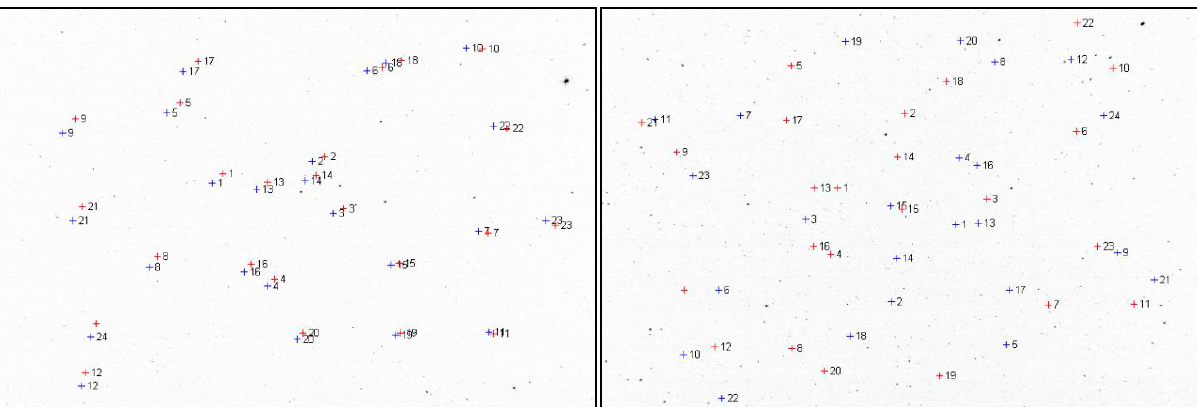
Figure 4. Predicted image positions of reference stars (blue) versus actual positions